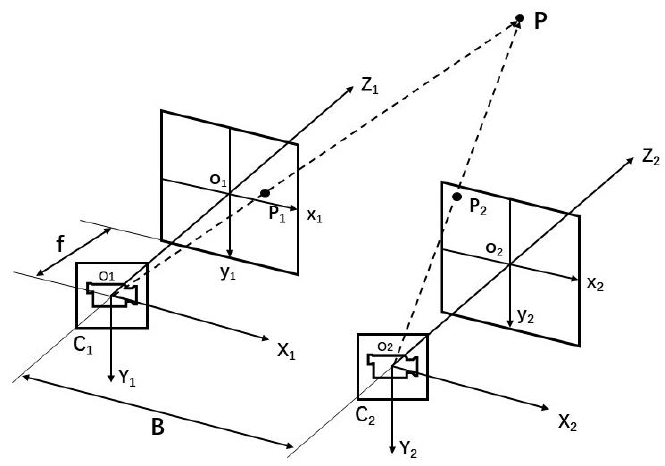
Figure 1. Geometric principle of the binocular stereo vision system.